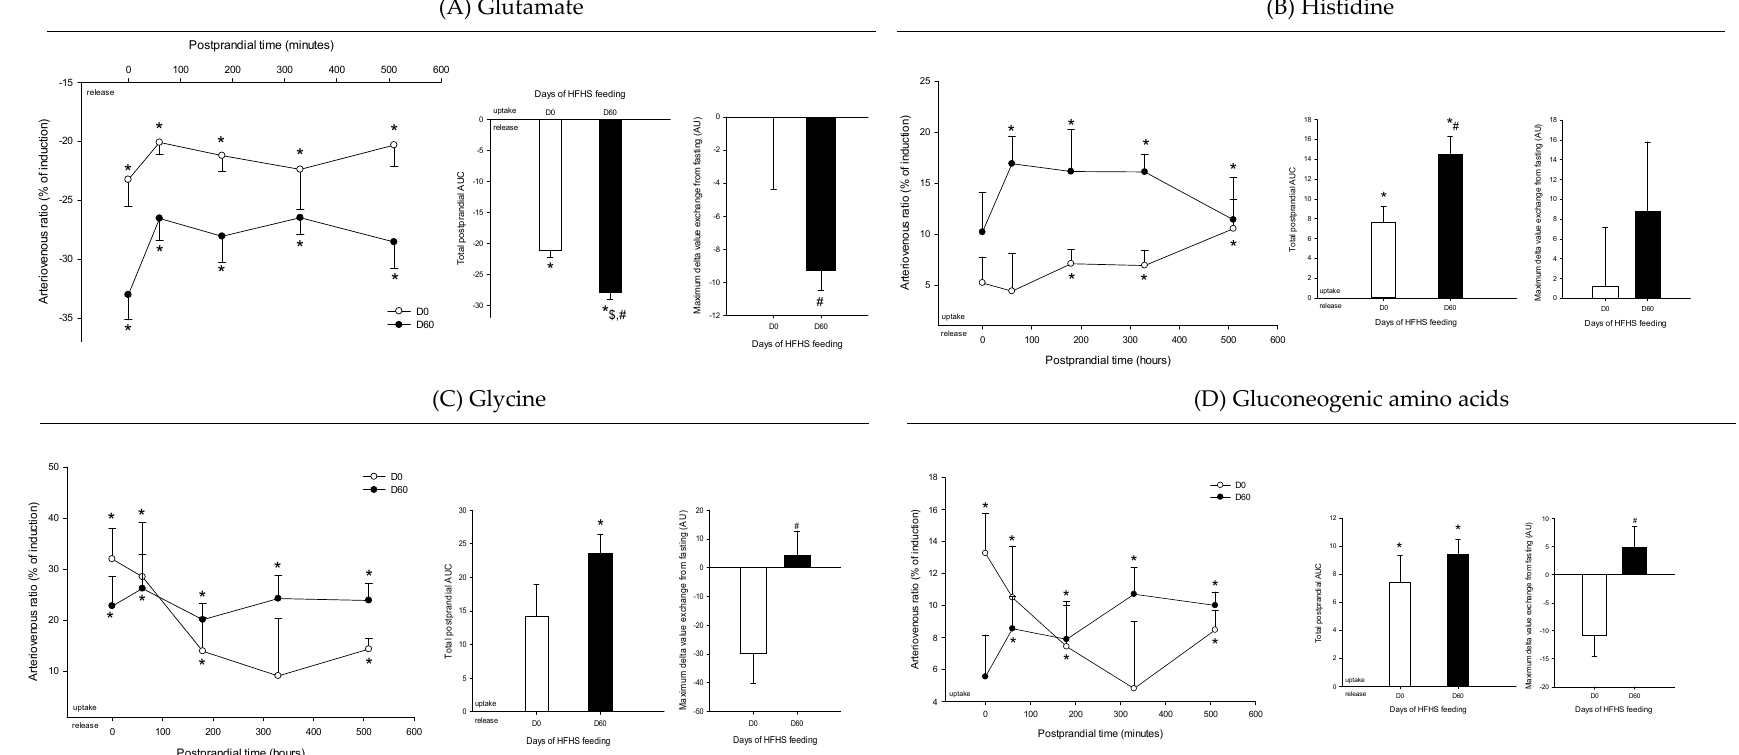
Figure 5. Arteriovenous fold-change (A/V) of ( A ) glutamate, ( B ) histidine, ( C ) glycine, and ( D ) gluconeogenic amino acids across the liver on five Yucatan mini-pigs submitted to a HFHS diet during two months. Data is presented in % of induction (mean + sem) and the exchange was analyzed using a repeated-measures t -student test. *, significantly different from 0 (equilibrium), p < 0.05. For the A/V ratios and total postprandial AUC, positive values = taken up by the organ; negative values = released by the organ. #, significantly different from D0, p < 0.05; $, significantly different from the fasting condition, p < 0.05. The maximum delta value exchange from fasting is also presented: the positive and negative values represent an increase or decrease exchange following the meal, respectively.